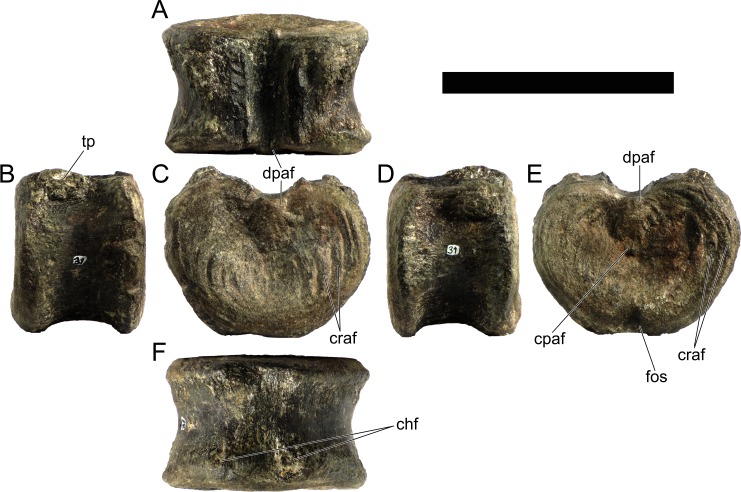
Caudal vertebra 23 of Miragaia longicollum MG 4863.A, dorsal, B, right lateral, C, anterior, D, left lateral, E, posterior, and F, ventral view. Chf, chevron facets, cpaf, central process of articular facet, craf, concentric ridges of articular facet, dpaf, dorsal process of articular facet, tp, transverse process. Scale bar equal to 10 cm.